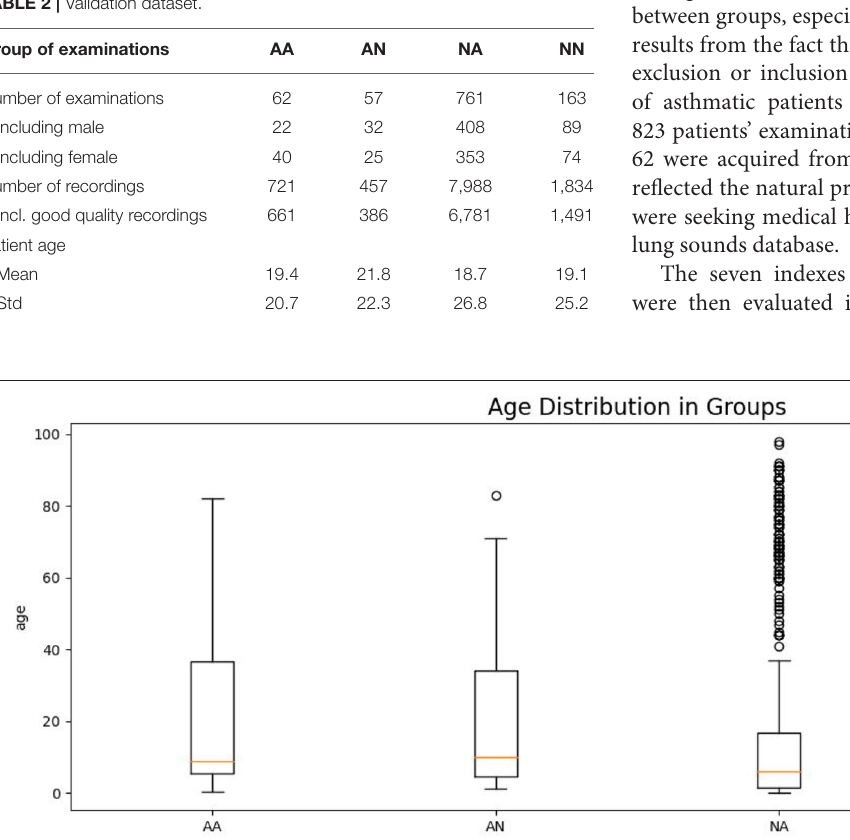
FIGURE 3 | Age distribution of patients in each comparison group shown as a box plot. The box extends from the lower to upper quartile values of the data, with a line at the median. The whiskers extend from the box to show the range of the data. Flyer points are those past the end of the whiskers.